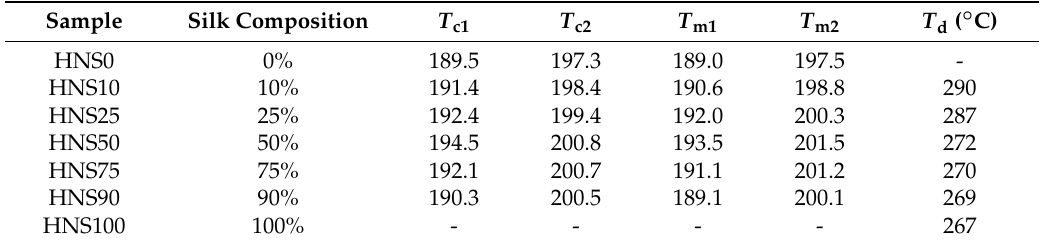
Table 2. Melting and crystallization temperatures determined from